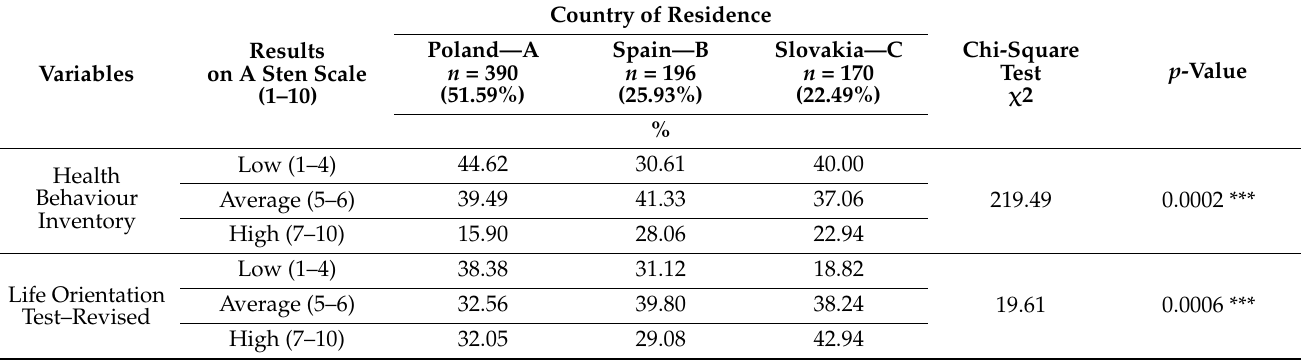
Table 3. Diversity of scores for overall health behaviours and dispositional optimism on the sten scale in the Polish, Spanish and Slovak studies.